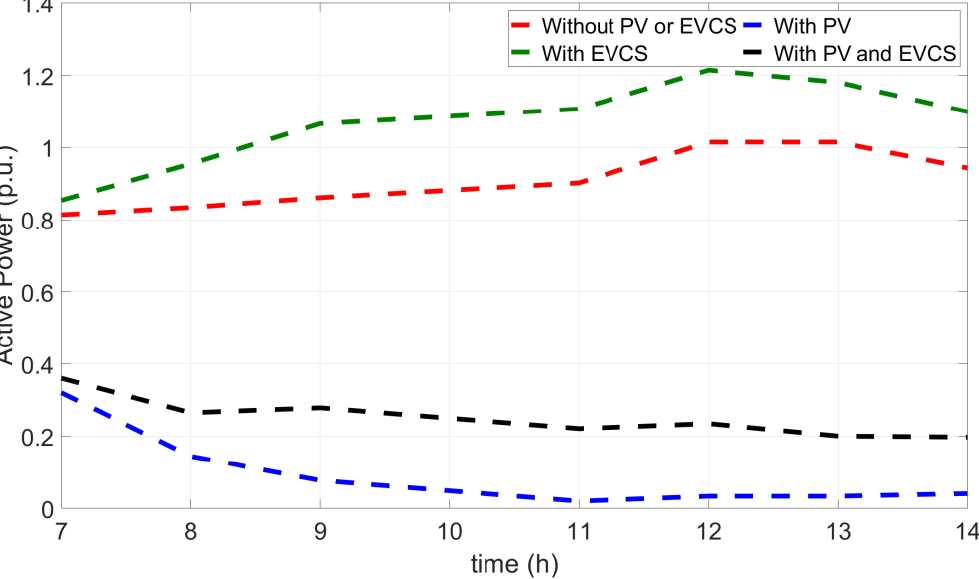
Figure 3. Hourly variations of the active power delivered from the PCC under the different cases.